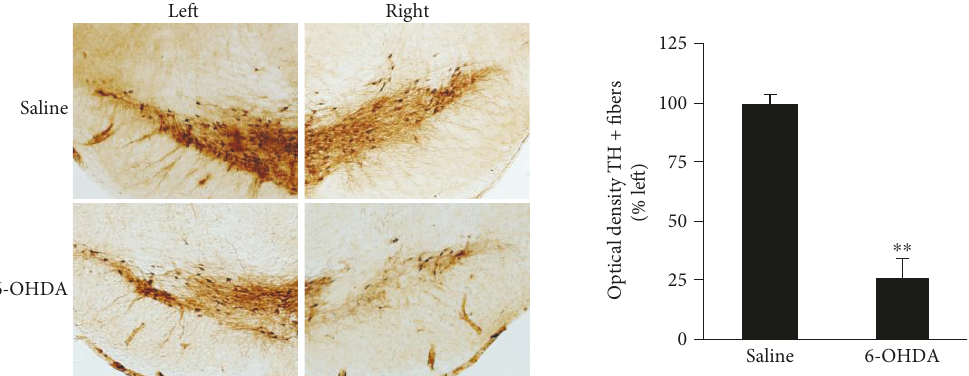
Figure 4: Expression of tyrosine hydroxylase (TH) in the substantia nigra of rats 7 days after saline (control and control+Ex) and 6-OHDA (PD and PD +Ex) injection. Note that expression of TH in the substantia nigra was observed at 7 days after 6-OHDA injection in rats checked randomly. Compared to the saline group, ∗∗ P < 0 01 . Control: control group; control +Ex: control plus exercise group; PD: Parkinson ’ s disease group; PD+Ex: Parkinson ’ s disease plus exercise group; 6-OHDA: 6-hydroxydopamine.